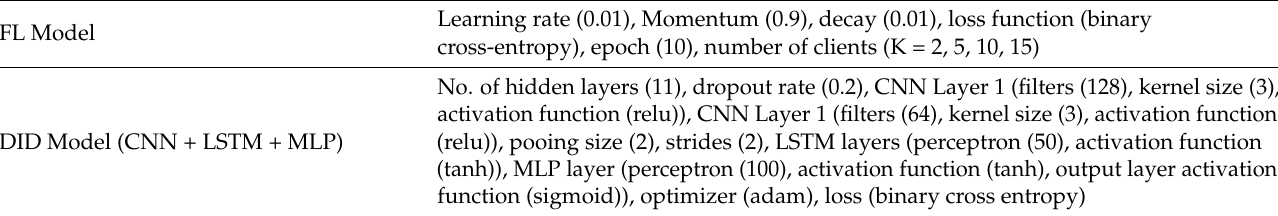
Table 2. Parameters used in the proposed